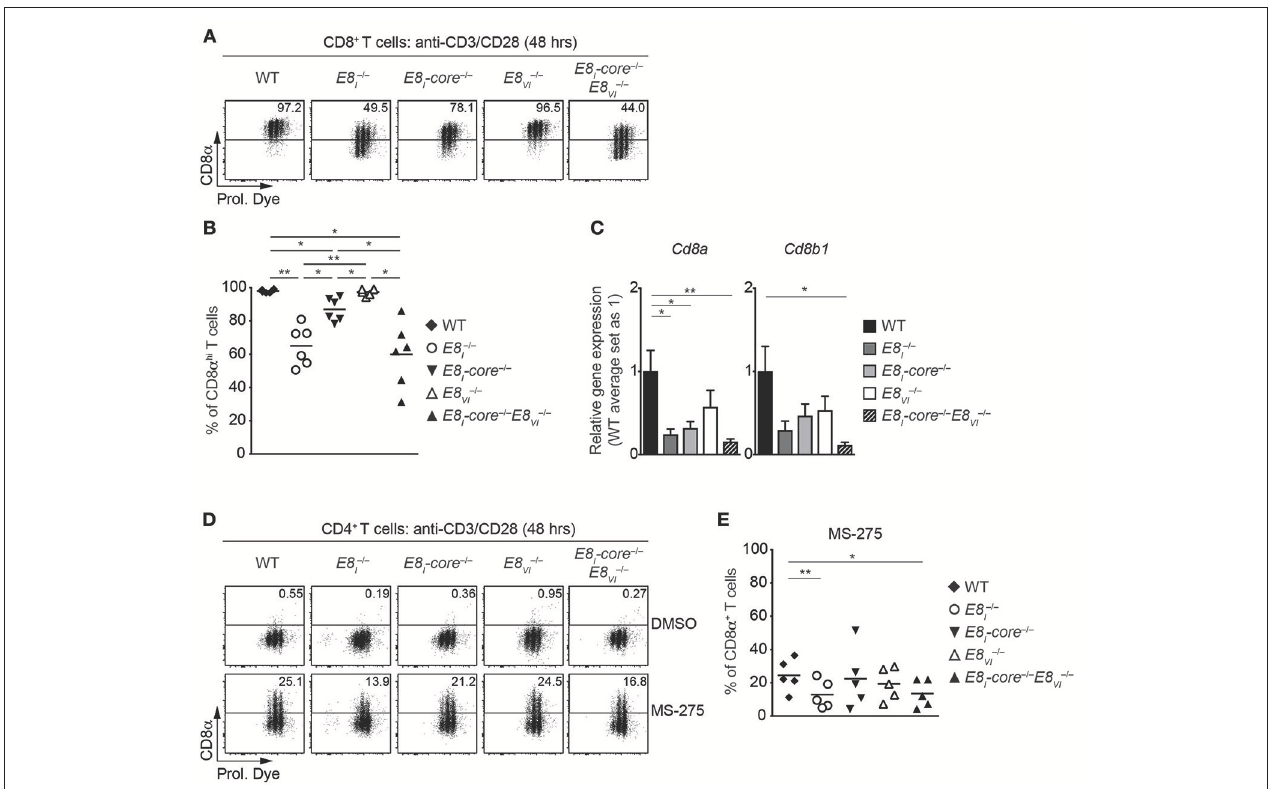
FIGURE 5 | E8 I -core and E8 VI function in activated CD8 + and HDAC inhibitor-treated CD4 + T cells. (A) Flow cytometry analysis showing CD8 α expression and Cell proliferation dye (Prol. Dye) dilution on activated CD8 + T cells isolated from wild-type (WT), E8 I − / − , E8 I - core − / − , E8 VI − / − , and E8 I - core − / − E8 VI − / − mice. Naïve CD8 + T cells were stimulated with plate-bound anti-CD3 and anti-CD28 antibodies for 48h. Numbers indicate the percentages of the CD8 α hi population. (B) Diagrams showing the percentages of CD8 α hi population within activated CD8 + T cells (48h after activation), isolated from wild-type (WT), E8 I − / − , E8 I - core − / − , E8 VI − / − and E8 I -core − / − E8 VI − / − mice. (C) qRT-PCR analysis showing Cd8a (left) and Cd8b1 (right) gene expression levels (normalized to the Hprt gene expression levels) in wild-type (WT), E8 I − / − , E8 I -core − / − , E8 VI − / − and E8 I - core − / − E8 VI − / − activated CD8 + T cells (72h after activation). The average expression levels in WT cells were set as 1. The summary of 5–6 biologically independent experiments is shown. Error bars indicate SEM. A one-way ANOVA analysis with repeated measures followed by Tukey’s multiple-comparison test was performed for statistical analysis. (D) Naïve CD4 + T cells were stimulated with plate-bound anti-CD3 and anti-CD28 antibodies for 48h, and were cultured in the presence of DMSO or MS-275 for the last 24h. Flow cytometry analysis showing CD8 α expression and Cell Proliferation Dye (Prol. Dye) dilution in DMSO- (upper panel) and MS-275-treated (lower panel) activated CD4 + T cells isolated from wild-type (WT), E8 I − / − , E8 I - core − / − , E8 VI − / − , and E8 I -core − / − E8 VI − / − mice. Numbers indicate the percentages of CD8 α + cells. (E) Diagrams showing the percentage of CD8 α + cells within MS-275-treated activated CD4 + T cells isolated from wild-type (WT), E8 I − / − , E8 I -core − / − , E8 VI − / − and E8 I - core − / − E8 VI − / − mice. (B,E) Each dot represents one mouse. Horizontal bars indicate mean values. A one-way ANOVA analysis with repeated measures followed by Tukey’s multiple-comparison test was performed for statistical analysis. (B,C,E) The p -values were defined as following: *, p < 0.05; **, p < 0.01; ***, p < 0.001. Data are representative (A,D) or show the summary (B,C,E) of 6 mice (A,B) , 5–6 samples (C) and 5 mice (D,E) analyzed in 6 (A,B) , 5–6 (C), and 4 (D,E) independent experiments.